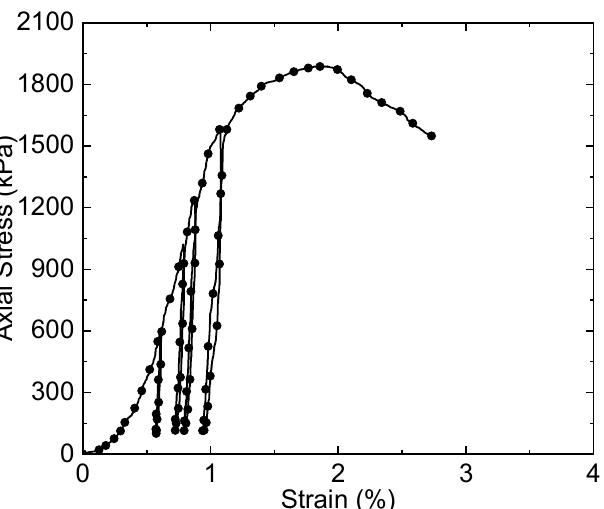
Figure 4. Load–unload–reload cycles applied to Macassa CPB (19% water content, 5.0% binder content, 28-day cure time).